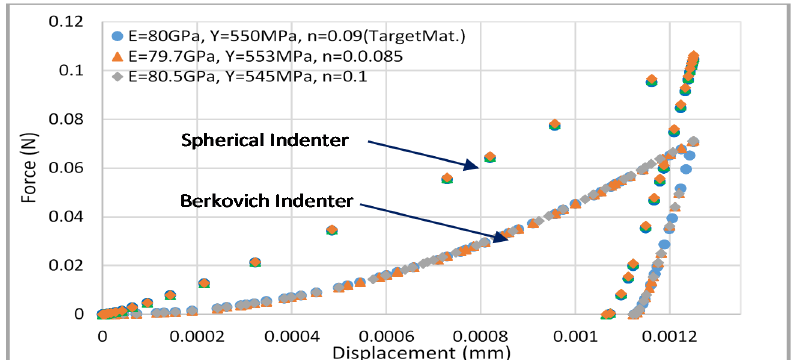
Figure 8. Comparison between the predicted load displacement curves using the optimal and target material properties for the S&B approach.